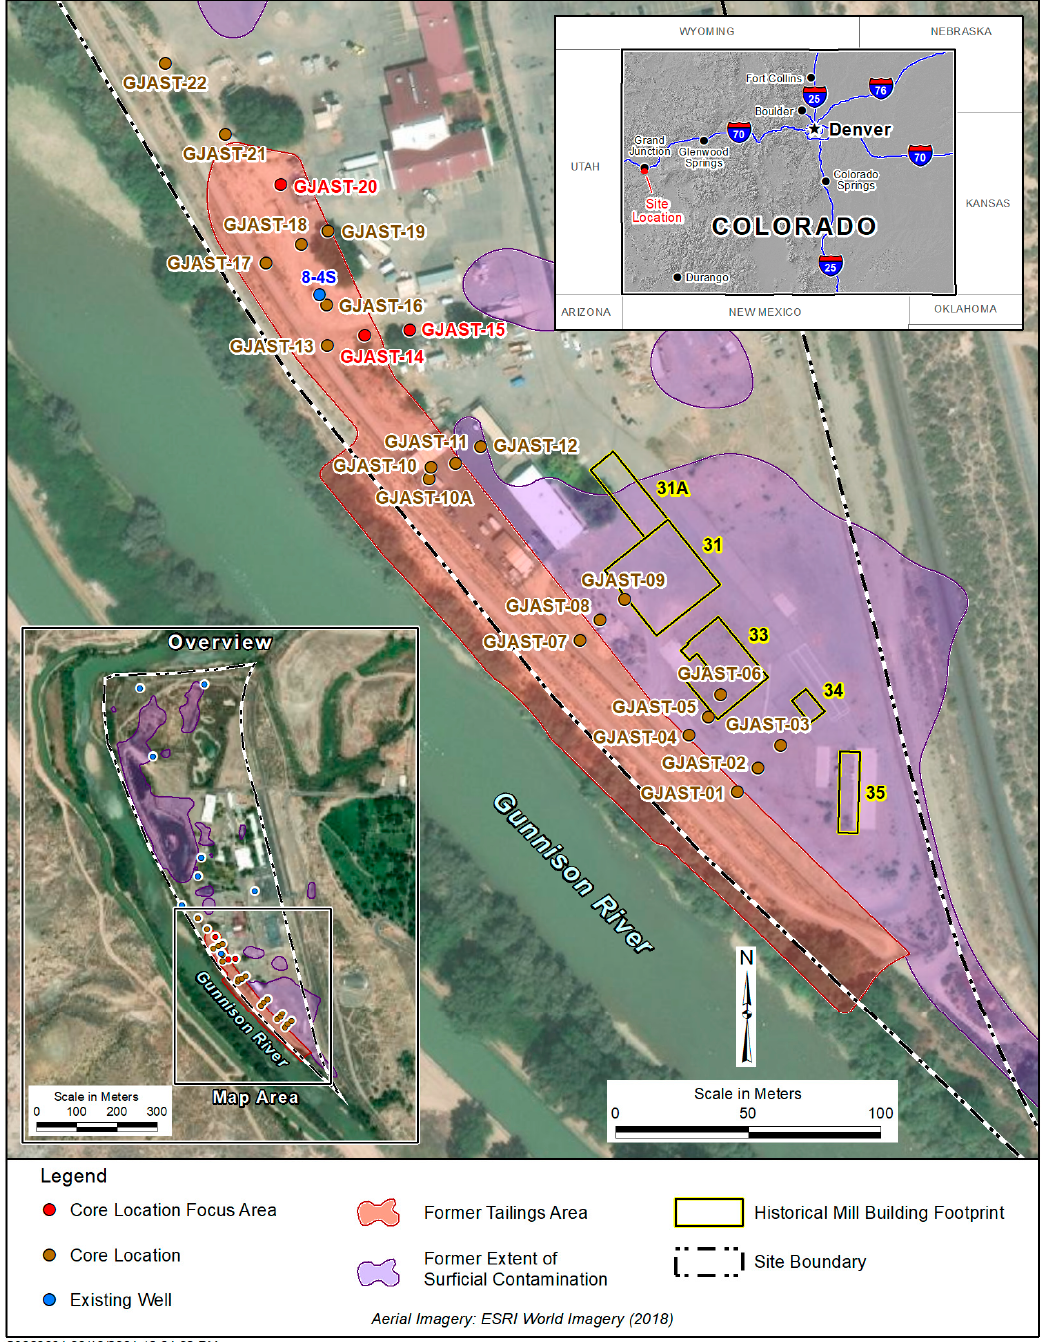
Figure 1. GJO site with the extent of former surface contamination, former tailings area, former mill buildings, coring locations, existing wells, and three focus areas. The river is flowing northward, and the side channel is an irrigation ditch. Figure modified from Johnson et al. [15].